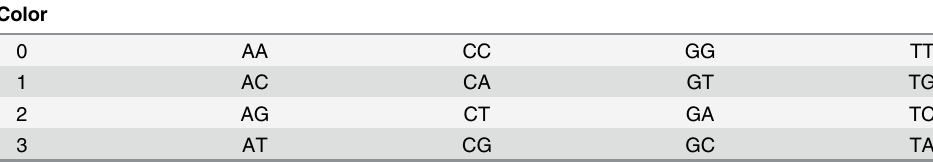
Table 1. 2-base encoding